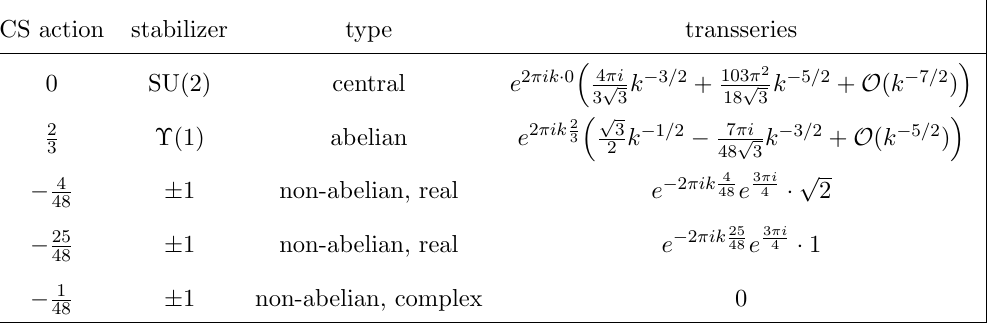
Table 18 . Transseries and classi(cid:12)cation of (cid:13)at connections on M ( factor of iq (cid:0) 1 = 48 = 2 p 2. The corresponding Weil representation is m + K = 12 + (cid:0)